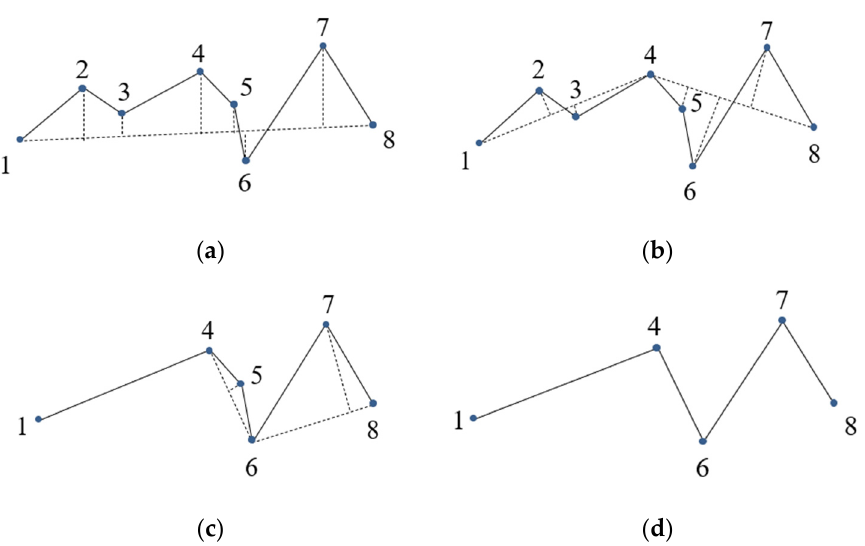
Figure 3. Schematic diagram of the Douglas–Peucker algorithm simplification. (a) Connect a straight line between the two points at the beginning and end of the curve and find the distance between the rest points and the line. (b) Select the maximum one to compare with the threshold value. If it is greater than the threshold, the point with the maximum distance from the line will be retained. Otherwise, all points between the two ends of the line will be rounded off, and we keep point 4. (c) According to the reserved points, the known curve is divided into two parts, and the first and second steps are repeated until there are no points to be rounded off. Finally, the coordinates of the curve points meeting the given accuracy limit are obtained. (d) Points 1, 4, 6, 7, and 8 are reserved, and other points are omitted to simplify the line.